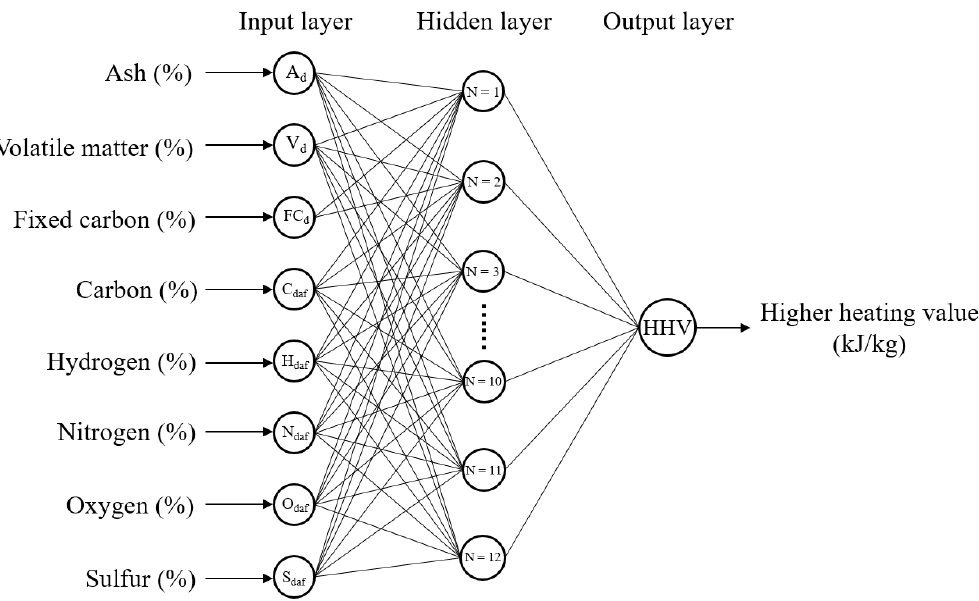
Figure 4. The architecture of the three-layered ANN model.